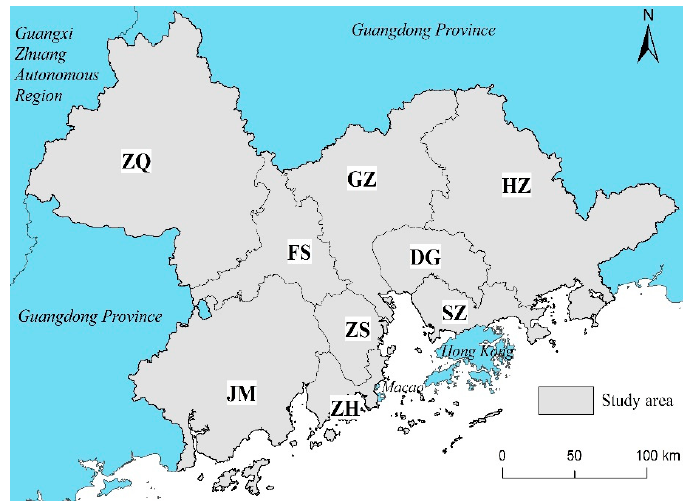
Figure 1. The Pearl River Delta urban agglomeration. ZQ: Zhaoqing; GZ: Guangzhou; FS: Foshan; JM: Jiangmen; ZS: Zhongshan; ZH: Zhuhai; DG: Dongguan; HZ: Huizhou; SZ: Shenzhen.